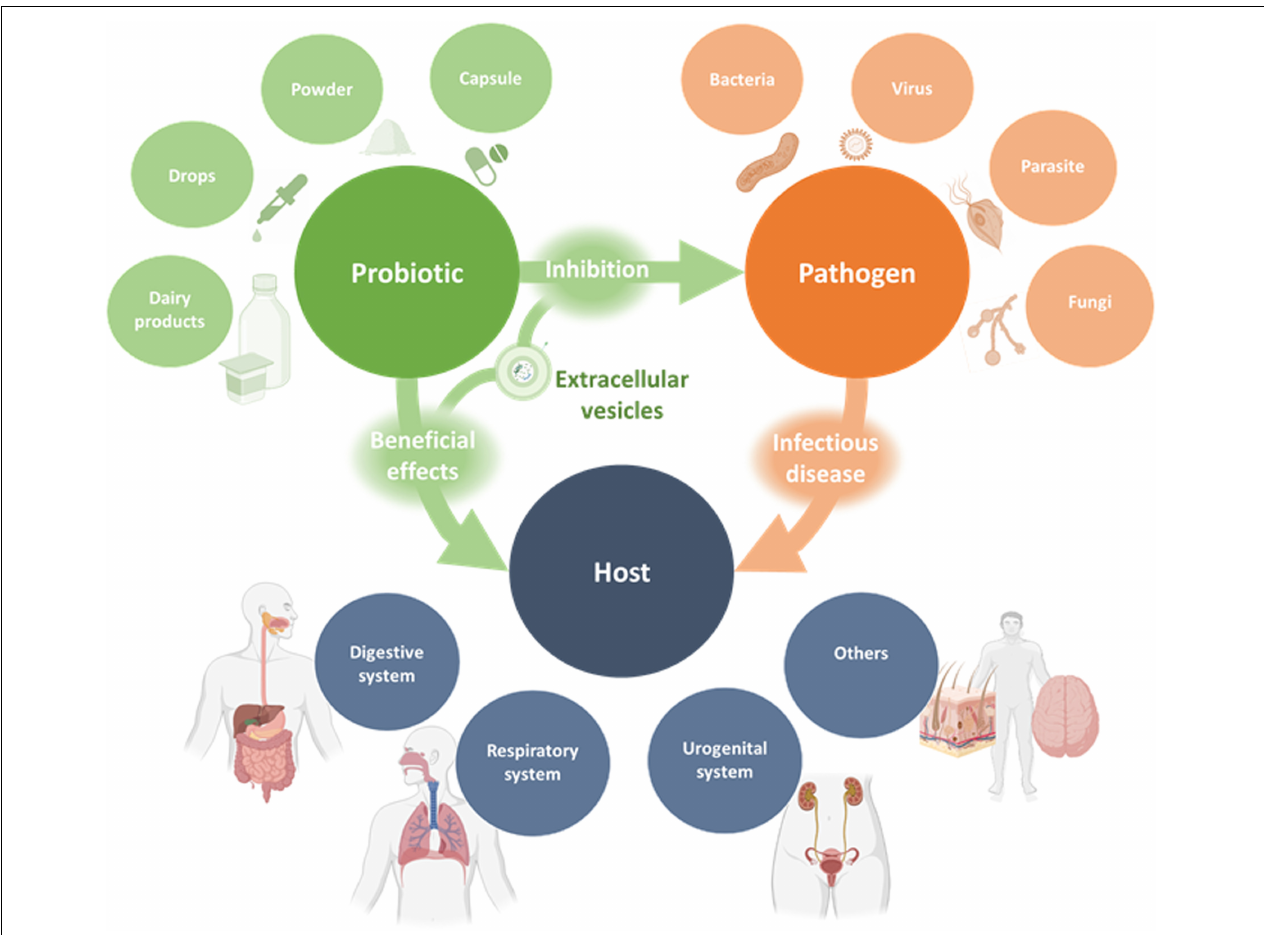
FIGURE 2 | Schematic representation of the interactions between probiotics, pathogens and the host. Probiotics in various dosage forms were shown to exert beneficial effects on different human organ systems for the prevention or treatment of infectious diseases. These effects are exerted indirectly or directly through pathogen inhibition and may be mediated, at least in part, by probiotic-derived